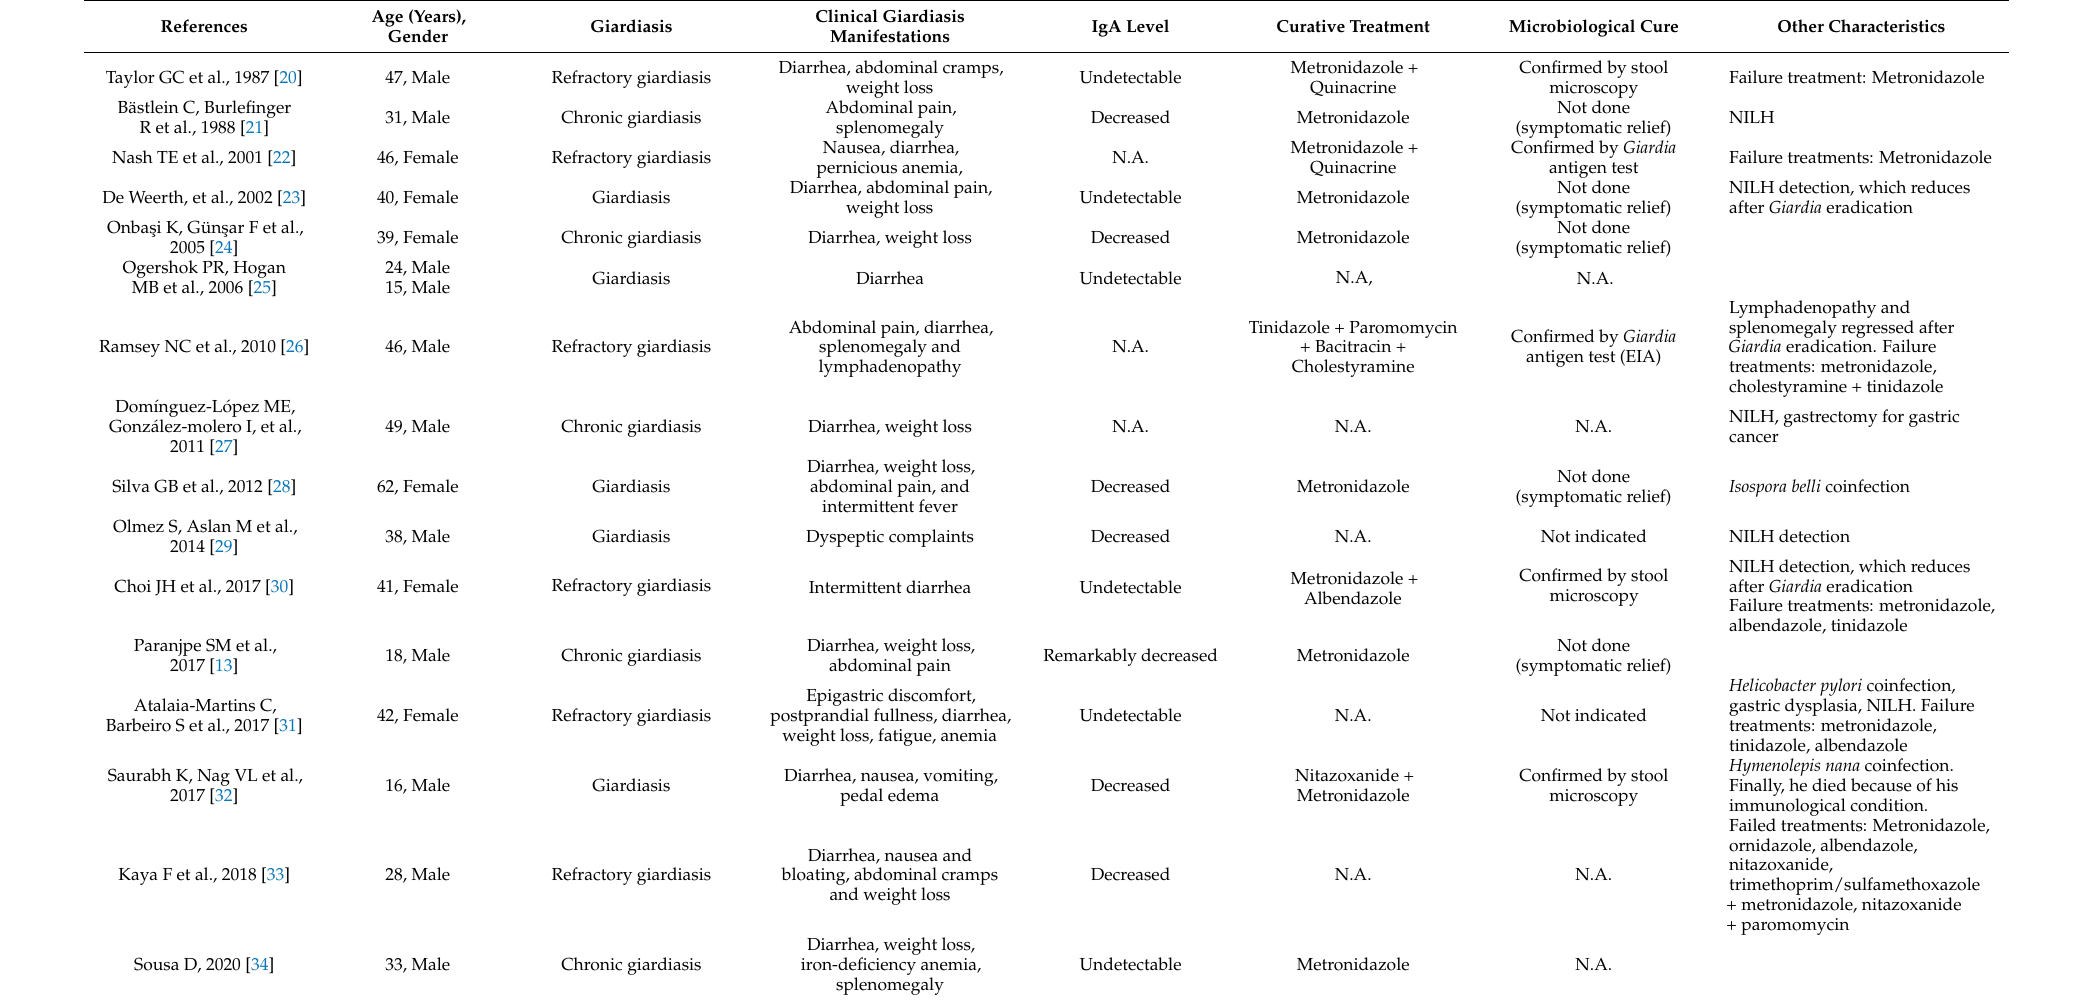
Table 3. Cases of giardiasis in CVID documented in the